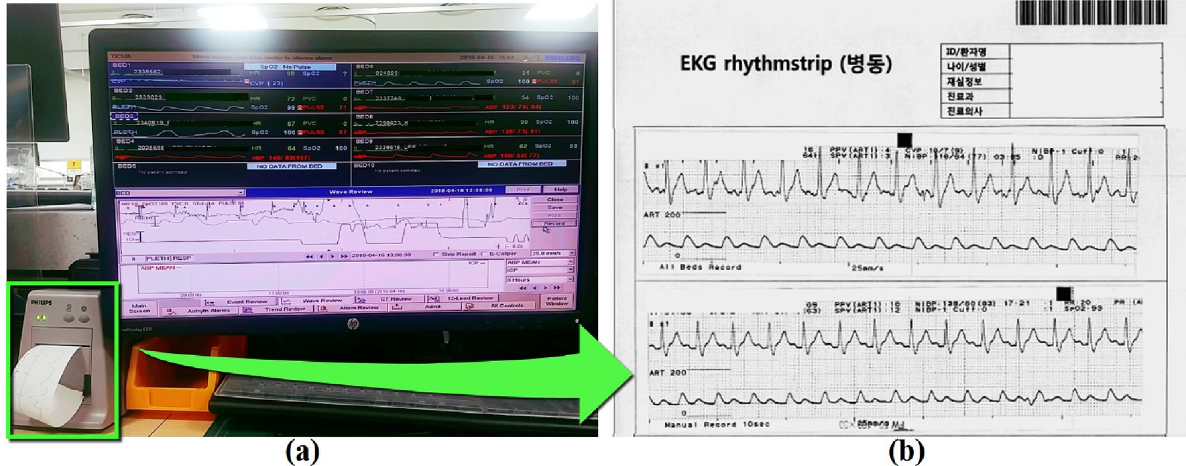
Fig 4. Patient monitoring interface (a) and how ECG signal data is archived on paper (b). When a notable event occurs, a clinical nurse records the time of the event and the corresponding patient condition. A PC located at the center of the TICU shows the ECG signal history for currently admitted patients. This PC is accessed to retrieve the ECG signal history. The green box in (a) shows how the ECG snippets are printed, prior to being pasted on the bar-coded paper in (b).